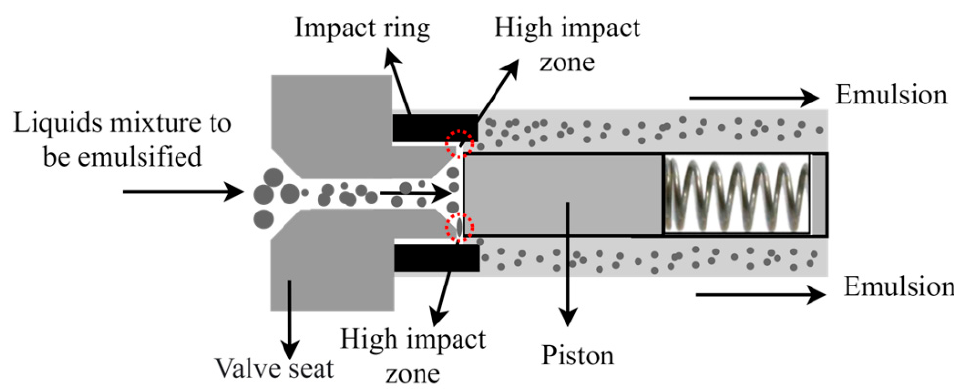
Figure 9. Schematic of the high-pressure valve homogenizer used to prepare emulsion with reduced size of